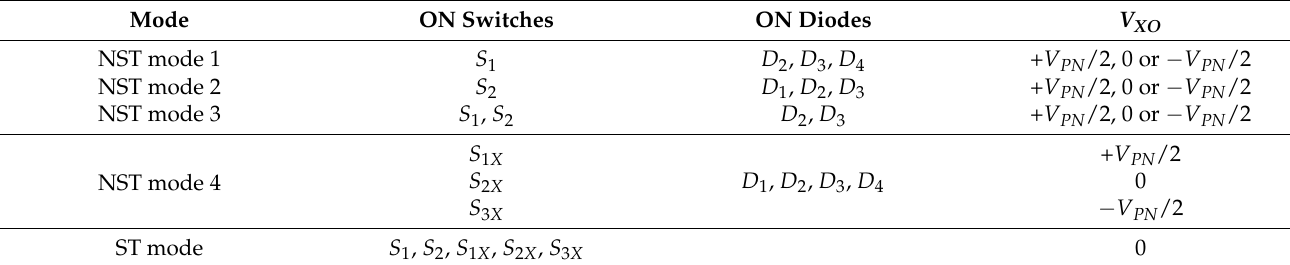
Figure 3. The modes of 3L-qSBT 2 I: ( a ) ST mode, ( b ) NST mode 1, ( c ) NST mode 2, ( d ) NST mode 3, and ( e ) NST mode 4.